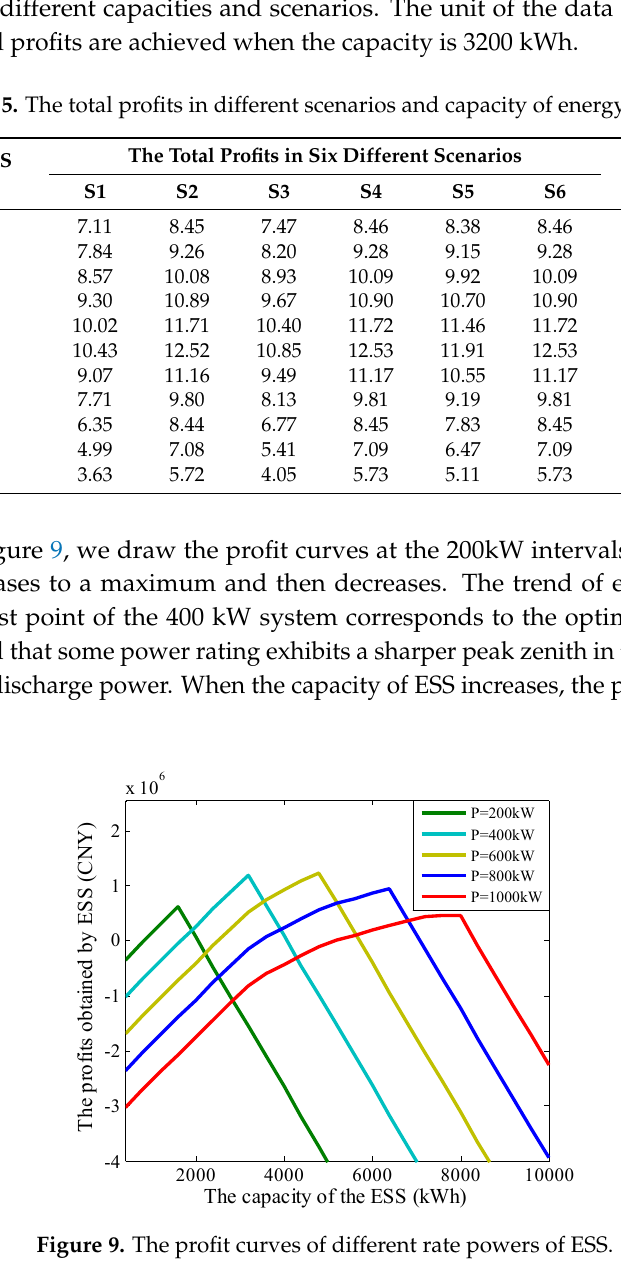
Table 6. The comparison of different batteries’ results obtained by two optimization methods.